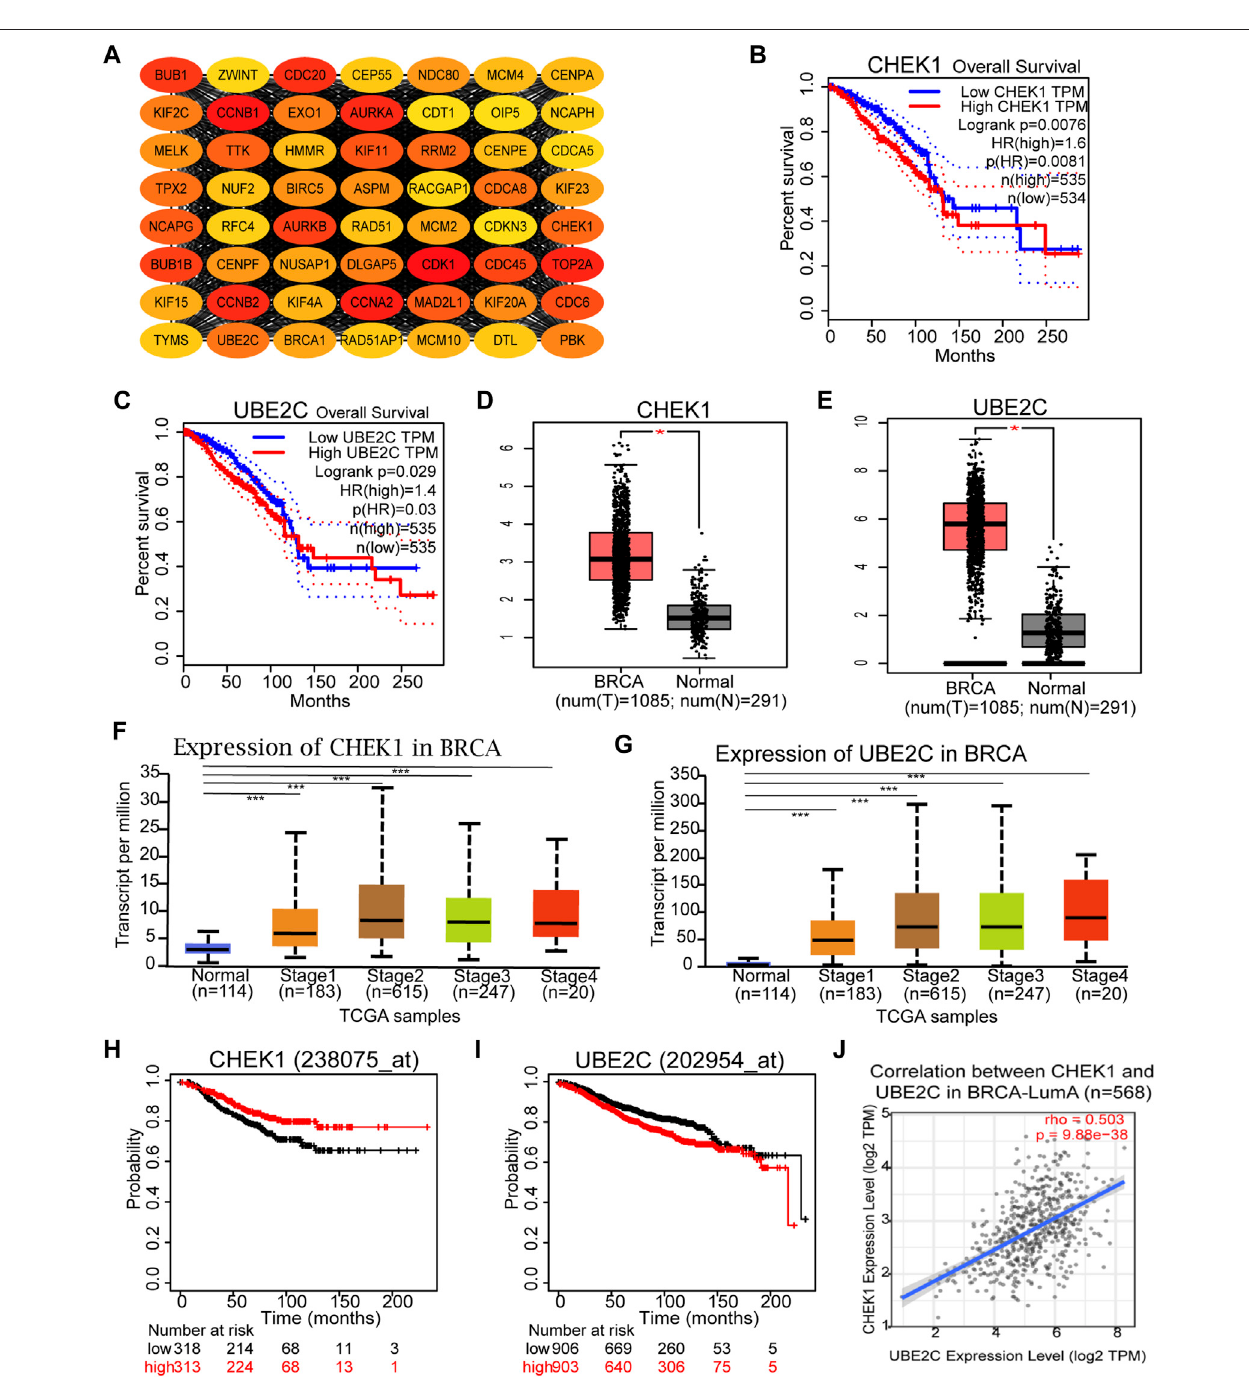
FIGURE 4 | Identi fi cation and validation of Hub genes in BRCA. (A) Identi fi cation of the top 10% key targets from PPI network in the yellow module. (B,C) Overall survivalofthetwohubgenecandidates inBRCA based ontheGeneExpressionPro fi lingInteractiveAnalysis(GEPIA) database. (D,E) GraphsshowingthemRNAlevels oftwohubgenecandidatesinBRCAtissuescomparedwithnormalcontrolsfromGEPIAdatabase.* p < 0.01wasconsideredasstatisticallysigni fi cant. (F,G) Expression ofCHEK1andUBE2CinBRCAbasedonindividualcancerstages. (H,I) Overallsurvivalofthetwohubgenesinluminal-AsubtypeofBRCAbasedonKaplanMeier- plotter. (J) Correlation Analysis of the two hub genes in luminal-A subtype of BRCA based on the TIMER2.0 database.